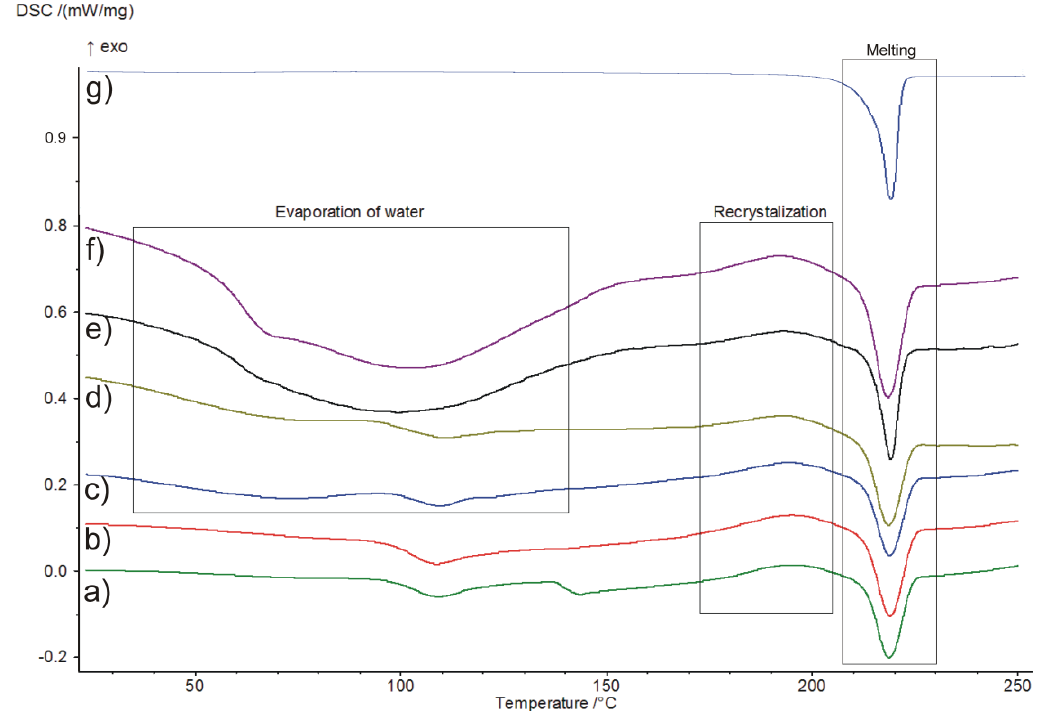
T p - peak melting temperature; T Onset - onset melting temperature; T Endset - endset melting temperature; ΔH f - enthalpy of fusion; T g - glass transition; ΔC p - heat capacity.